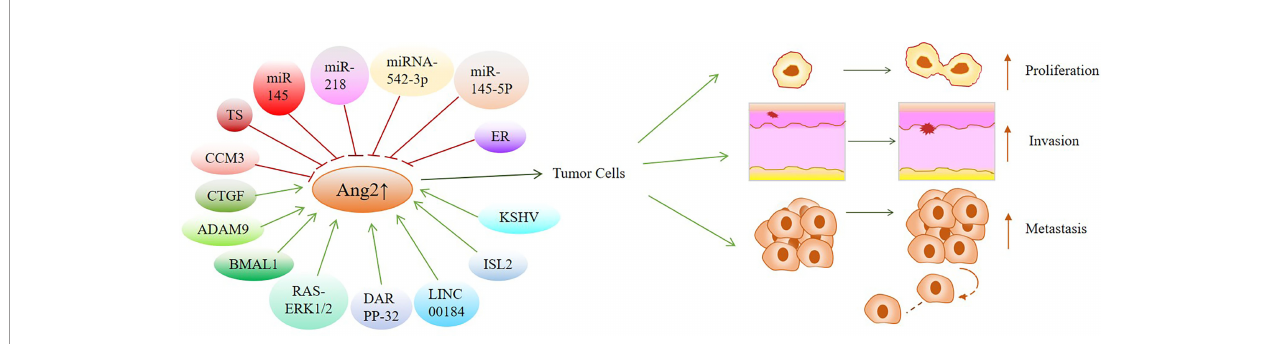
FIGURE 2 | Overview of factors or signal pathways that regulate Ang2 expression in various cancers: These factors or signaling pathways regulate Ang2 expression to mediate the occurrence and development of cancers, which may be potential targets for cancer treatment. Green arrows indicate positive effects. Red perpendicular bars indicate negative effects.